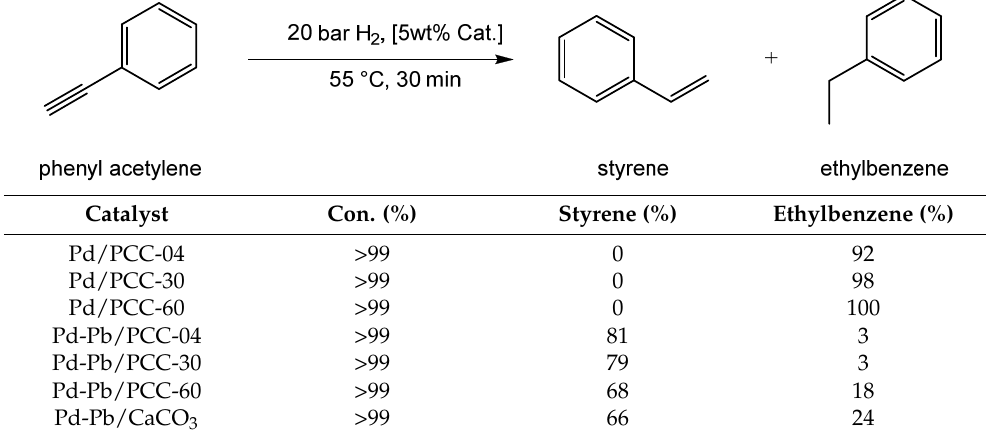
Table 2. Catalysts screening with phenylacetylene as a model substrate a .